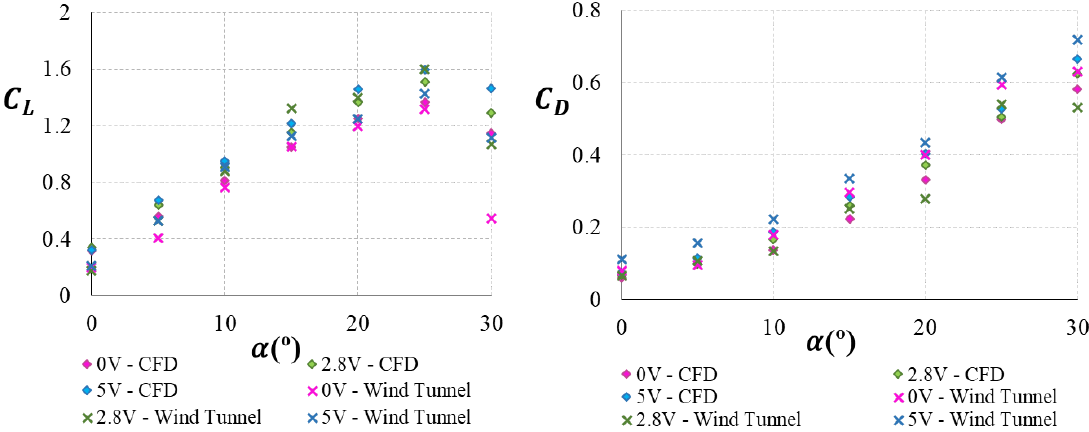
Figure 16. Control volume and wake volume meshed ( left ) and unstructured mesh of the MAV ( right ). ( U ∞ = 10 m/s,